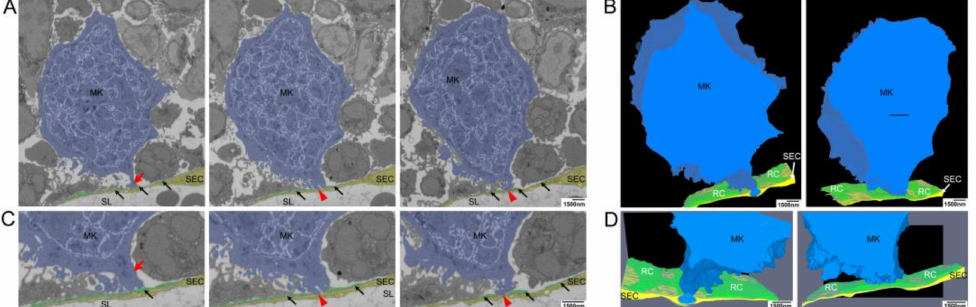
Figure 5. Electron microscopical analysis of local retraction of CAR-cells (reticular cells, RCs) and disintegration of the BL at distinct contact sites of megakaryocyte (MK) protrusions. ( A ) Selected images from single SBF-SEM slices showing a MK (blue) adjacent to the sinusoidal endothelial cells (SECs, yellow). MK protrusions provoke local retraction of RCs (green) at two distinct contact sites where they are associated with the endothelial cell layer. ( B ) Large-volume reconstruction of the SBF-SEM slices presented in ( A ) demonstrating the relationship between a MK protrusion (blue), RCs (black arrows) and SECs (yellow). MK protrusions provoke local retraction of RCs (green) at two distinct sides of SECs contact while these contact sides are still surrounded by RC processes. ( C ) Selected images from single SBF-SEM slices of ( A ) at higher magnification showing a MK protrusion in close association with the blood-BM-barrier. Although the MK protrusion is in close association with this barrier, RCs still cover the endothelial lining to a large extend (red arrow). RCs are retracted locally at two distinct sites where the MK protrusion is associated with the endothelial cell layer (red arrowheads) while the contact sides are still surrounded by reticular cell processes (black arrows). ( D ) Large-volume reconstruction of the SBF-SEM slices presented in ( B ) at higher magnification. SBF-SEM dataset: Reconstruction of a 3.9 µ m volume: 132 sections, 10 nm × 10 nm × 30 nm voxel size. BM of the diaphysis region obtained from murine ulnae. Source data are available for this figure. Sinusoidal lumen (SL); Protrusion (P); Marginal zone